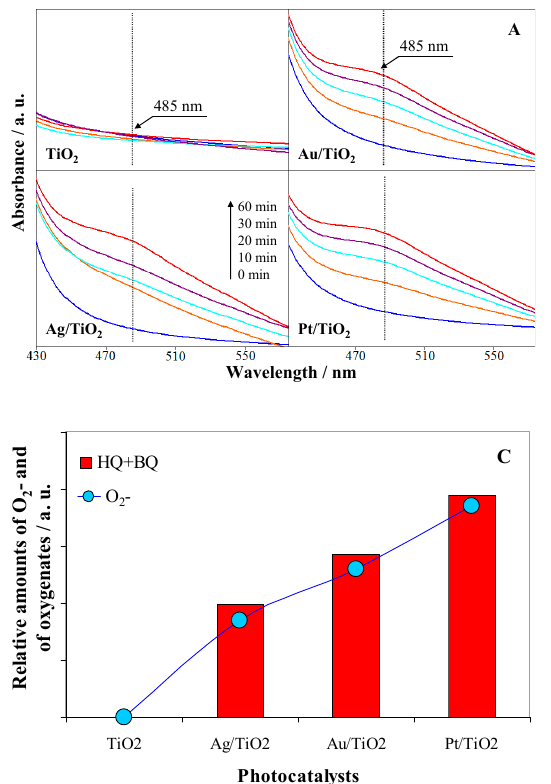
O 2- Figure 9. Survey of O 2 − production, by monitoring formazan specific absorbance, over the catalysts exposed to visible light ( λ > 420 nm). In the UV region, both  OH radicals and O 2 − are produced, the former on TiO 2 and the second on metals. The  OH oxidizes non-selectively the organic substrate(s) to CO 2 and H 2 O. The reactions implying  OH participation are important for environmental applications, where the scope is to mineralize rapidly the organic pollutant to